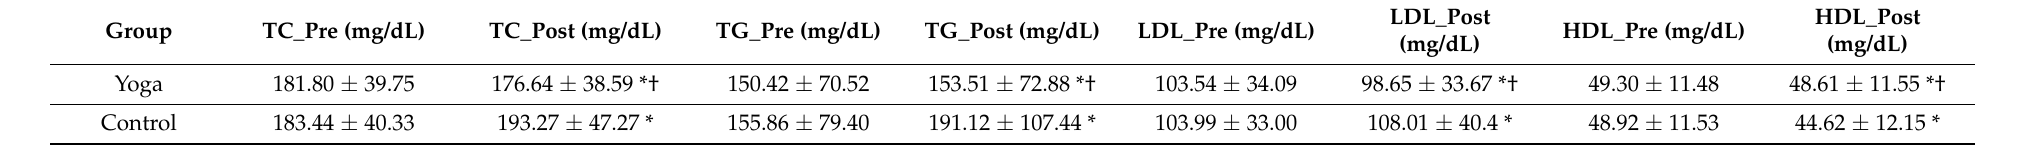
Table 2. Changes in lipid variables before and after three months in the two groups. N = 8116 (Yoga-3933, Control-4183).